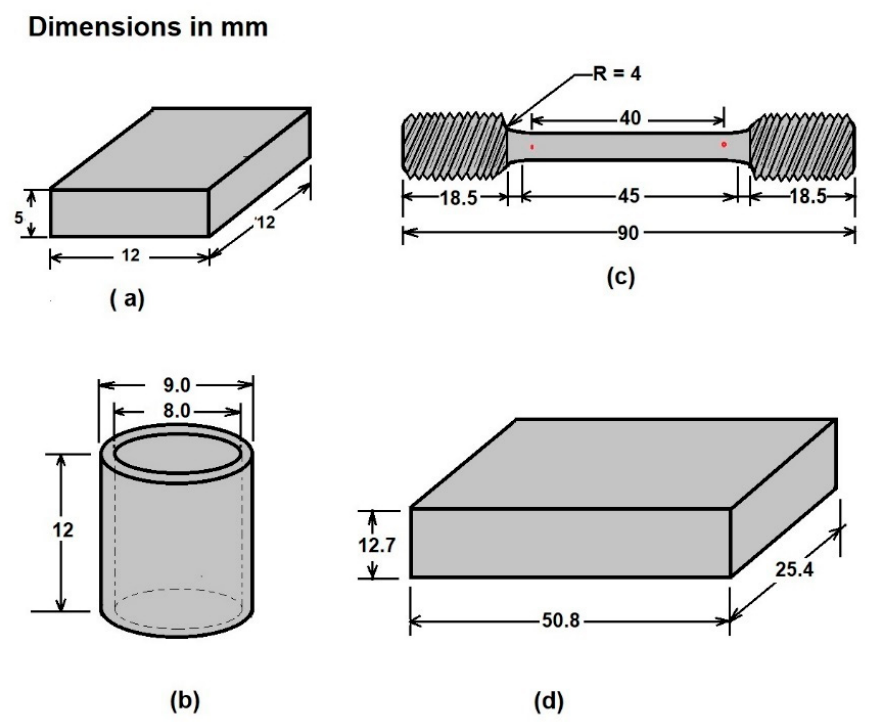
Figure 1. Schematic representation of the three configurations of samples used for analyzing ( a ) layer thickness and microhardness, ( b ) corrosion tests, ( c ) tensile tests, and ( d ) wear tests.